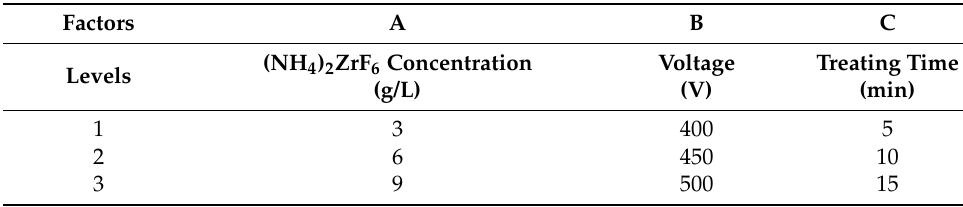
Table 1. Factors and levels of the orthogonal